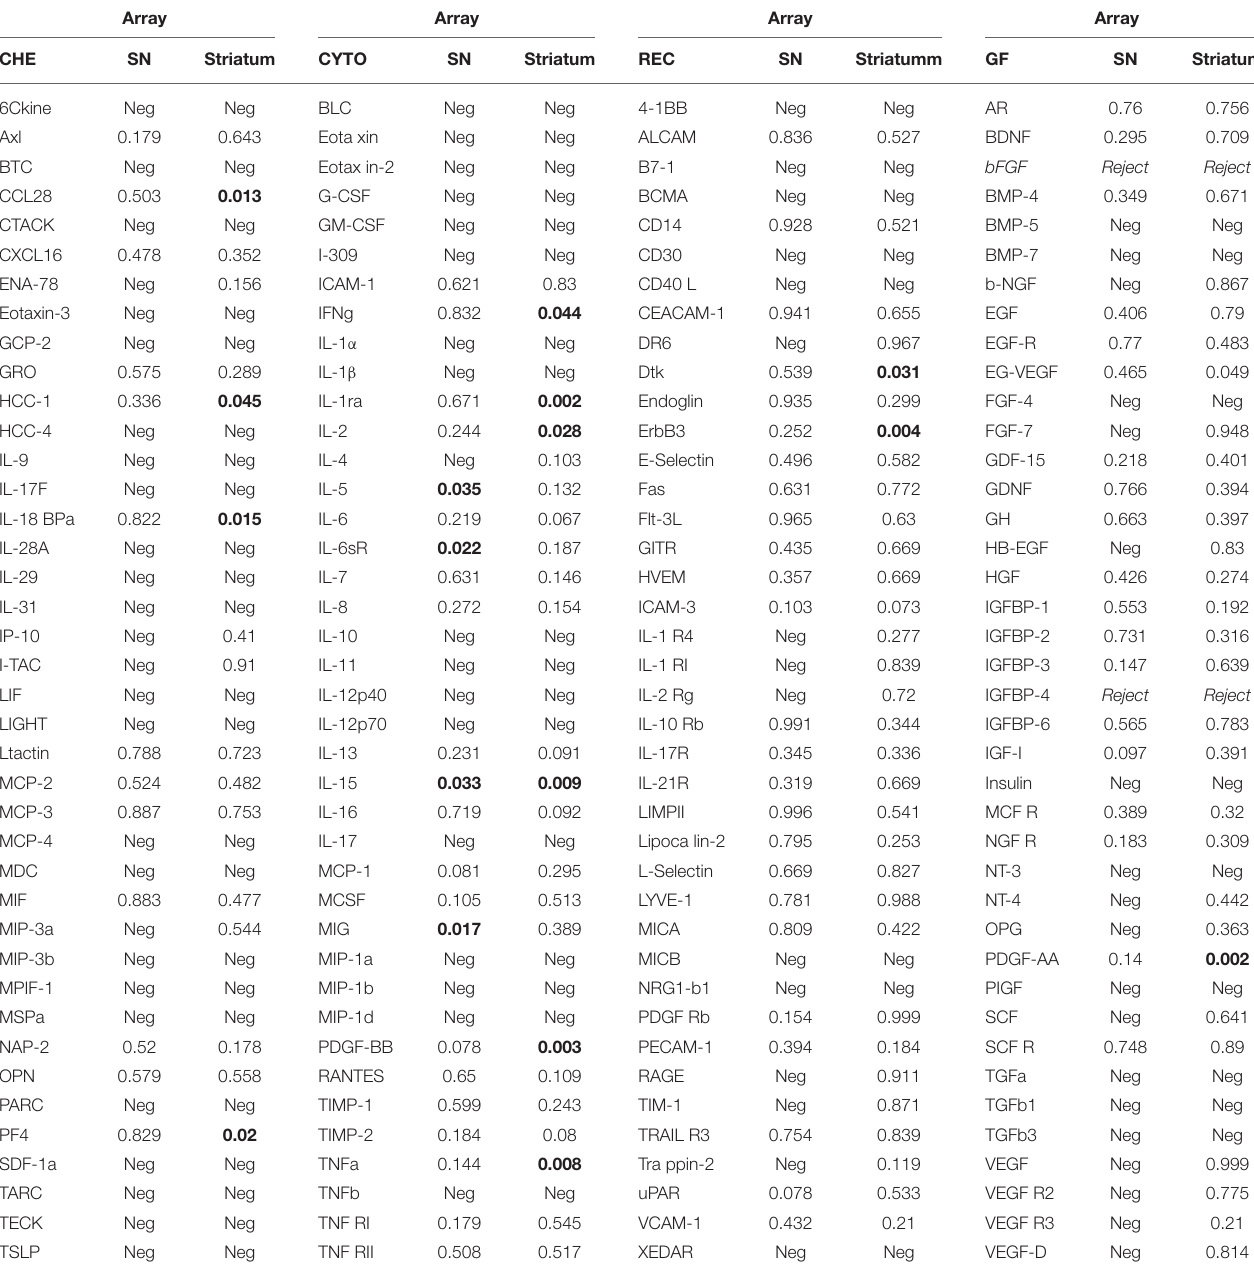
TABLE 3 | Summary of One-way ANOVA results. Array Array